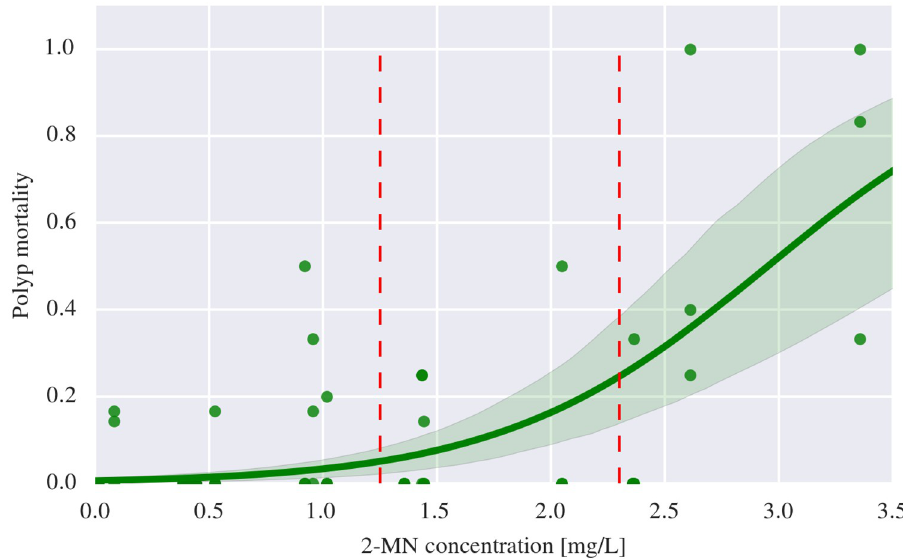
Fig 5. Dose-response curve for 2-methylnaphthalene exposure and polyp mortality ( n = 60). The regression line with a 95% confidence interval indicates that there is indeed a positive correlation between polyp mortality and 2-methylnaphthalene exposure. Some data points have similar values, and hence, overlap in the plot. The vertical red dashed lines indicate the 2-methylnaphthalene category thresholds and coincide with the 5% and 25% mortality levels (LC5 and LC25, respectively). The corresponding 2-methylnaphthalene concentrations are 1.25 mg L − 1 and 2.3 mg L − 1 ,